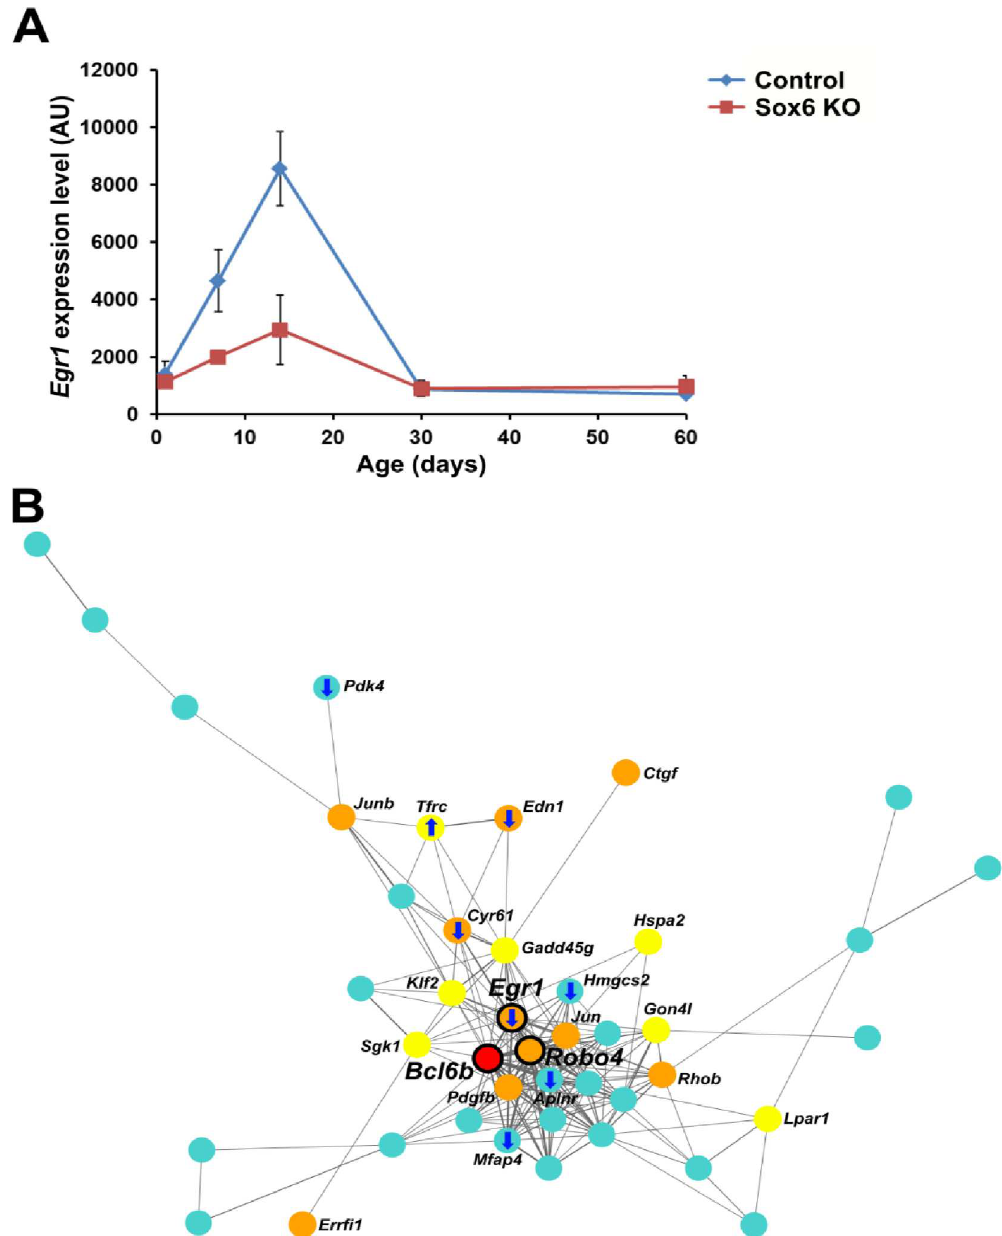
Fig 4. Egr1 is downregulated in the Sox6 KO heart. (A) Differential expressionof Egr1 in control and Sox6 KO hearts revealed by our microarrayanalysis. AU: arbitrary unit. (B) A weightedgene co-expression networkof the cluster J4. A core network modulewith a 0.05 minimum connectivity is demonstrated togetherwith information on gene functions (GO terms) and geneexpression. Genes related to vasculature development (GO:0001944), cell differentiation(GO:0030154) and both are shown in red, yellow, and orange, respectively,whileother genes are shown in sky blue. Identified hub genes are indicatedby black outlines with larger labels. One of the hub genes ( Bcl6b )is also shown in red becauseit is known to be involvedin angiogenesis(see text). The width of edges (lines betweengenes) reflects the strength of TOM-based connectivitybetweengenes (i.e. the degreeof co-expression). Directionsof expressionchangeat P7 and/or P14 in the Sox6 KO heart are indicatedby